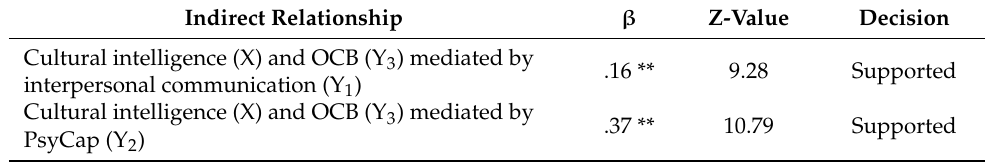
Table 6. Mediation relationship